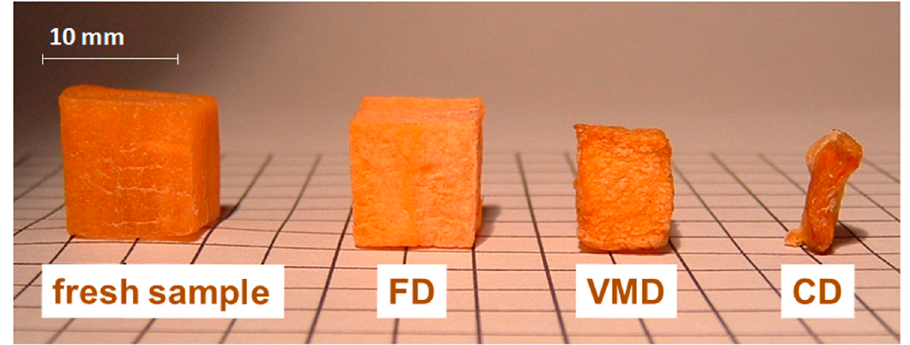
Figure 3. Shrinkage of carrot cubes dehydrated by freeze-drying (FD), vacuum-microwave drying (VMD) and convective drying (CD).